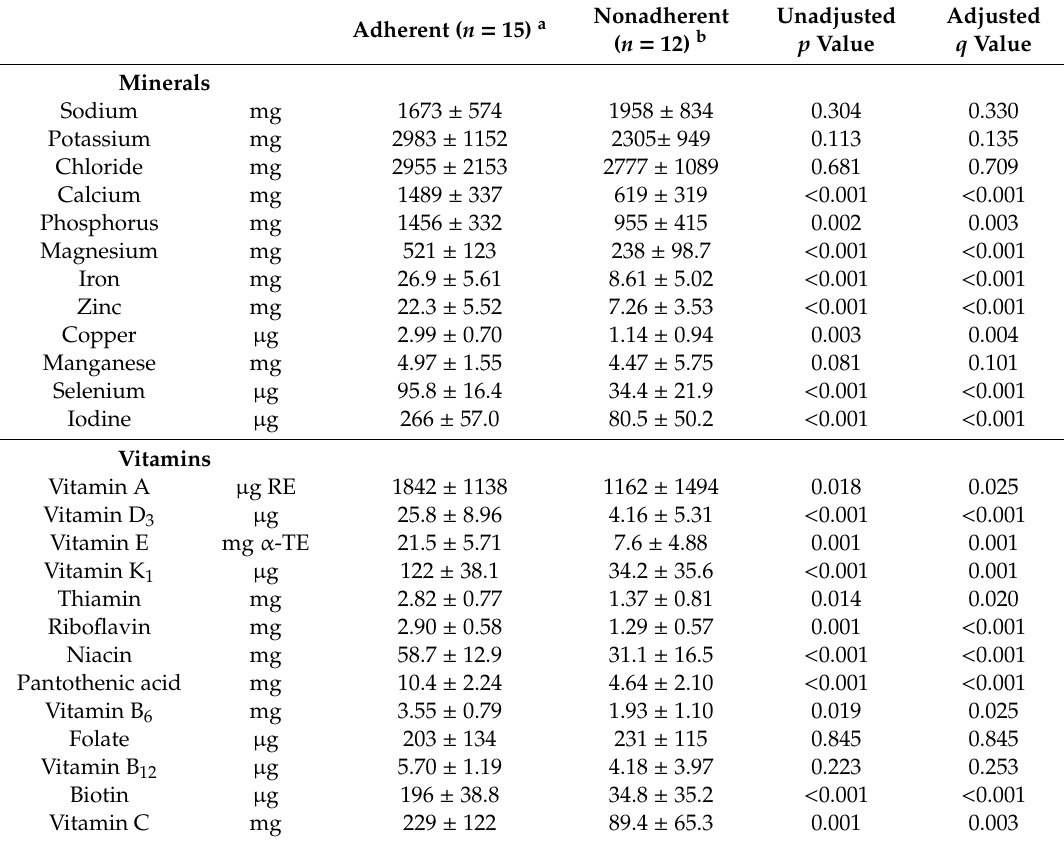
Table 2. Micronutrient Intakes in Adherent and Nonadherent